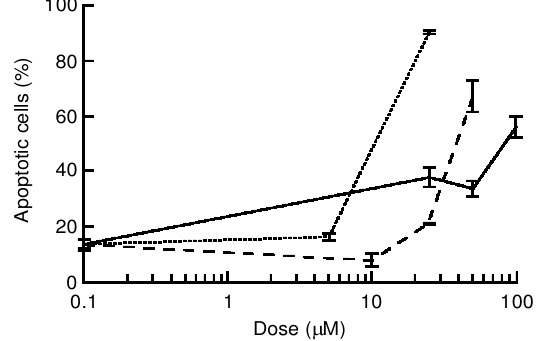
FIG. 1. Dose-response curves for apoptosis caused by NF- k B inhibitors. RAW 264.7 cells were incubated for 18 h with doses of PDTC (Ð Ð Ð ), TPCK (-----) and calpain I inhibitor (.....) in the range 0 ± 100 m M. Dosage data is plotted on a log scale. Percentage of apoptotic cells was quanti® ed by counting the number of cells with morphologic character- istics of apoptosis per 100 cells using acridine orange staining. Calpain I inhibitor (25 m M), TPCK (50 m M) and PDTC (100 m M) all caused highly signi® cant (P , 0 · 001) increases in apoptosis compared to controls. Error bars represent SEM. Each experiment was repeated at least three times.